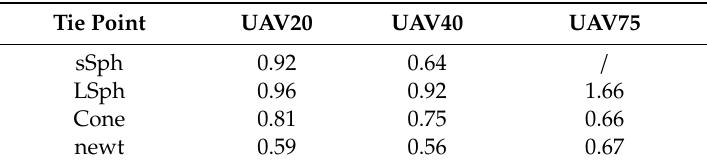
Table 7. The RMSE 2 D on check points, following the registration of UAV and TLS point clouds, taking into account the used tie point (in cm).